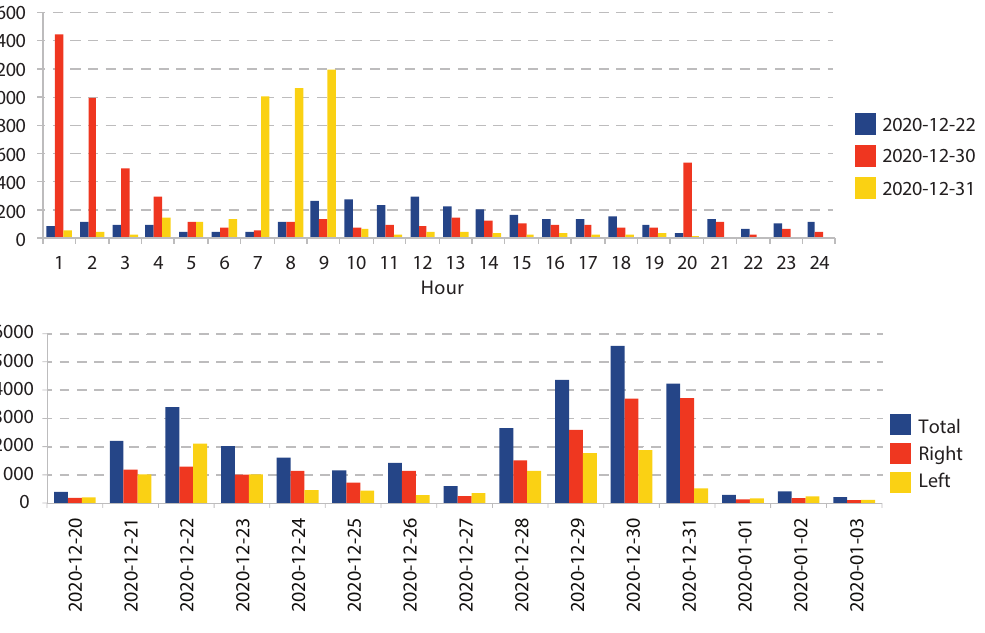
Figure 20. Summary of the experimental data obtained by the sensor: (a) accounting direction; (b) accounting time of the